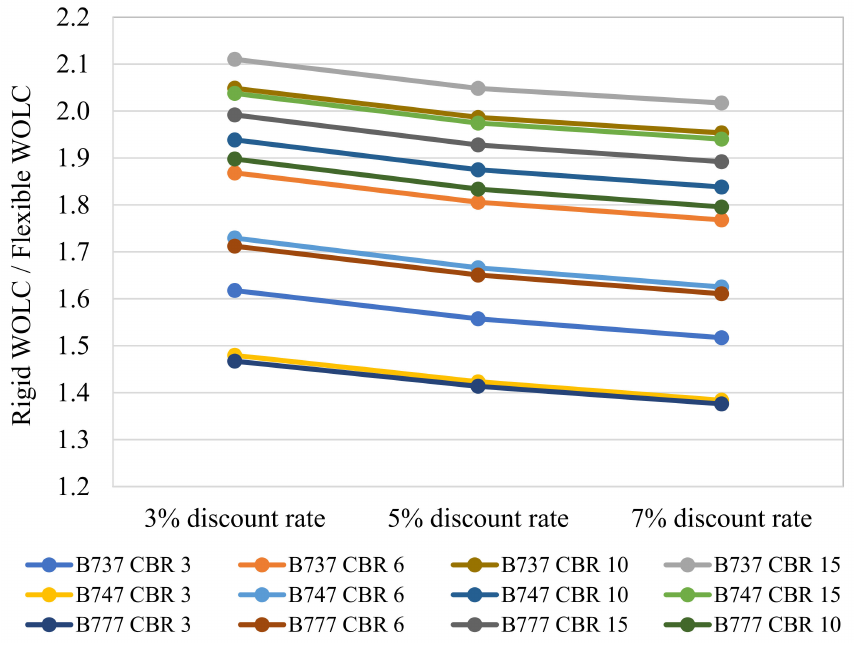
Figure 6. Effect of discount rate on rigid/flexible WOLC cost